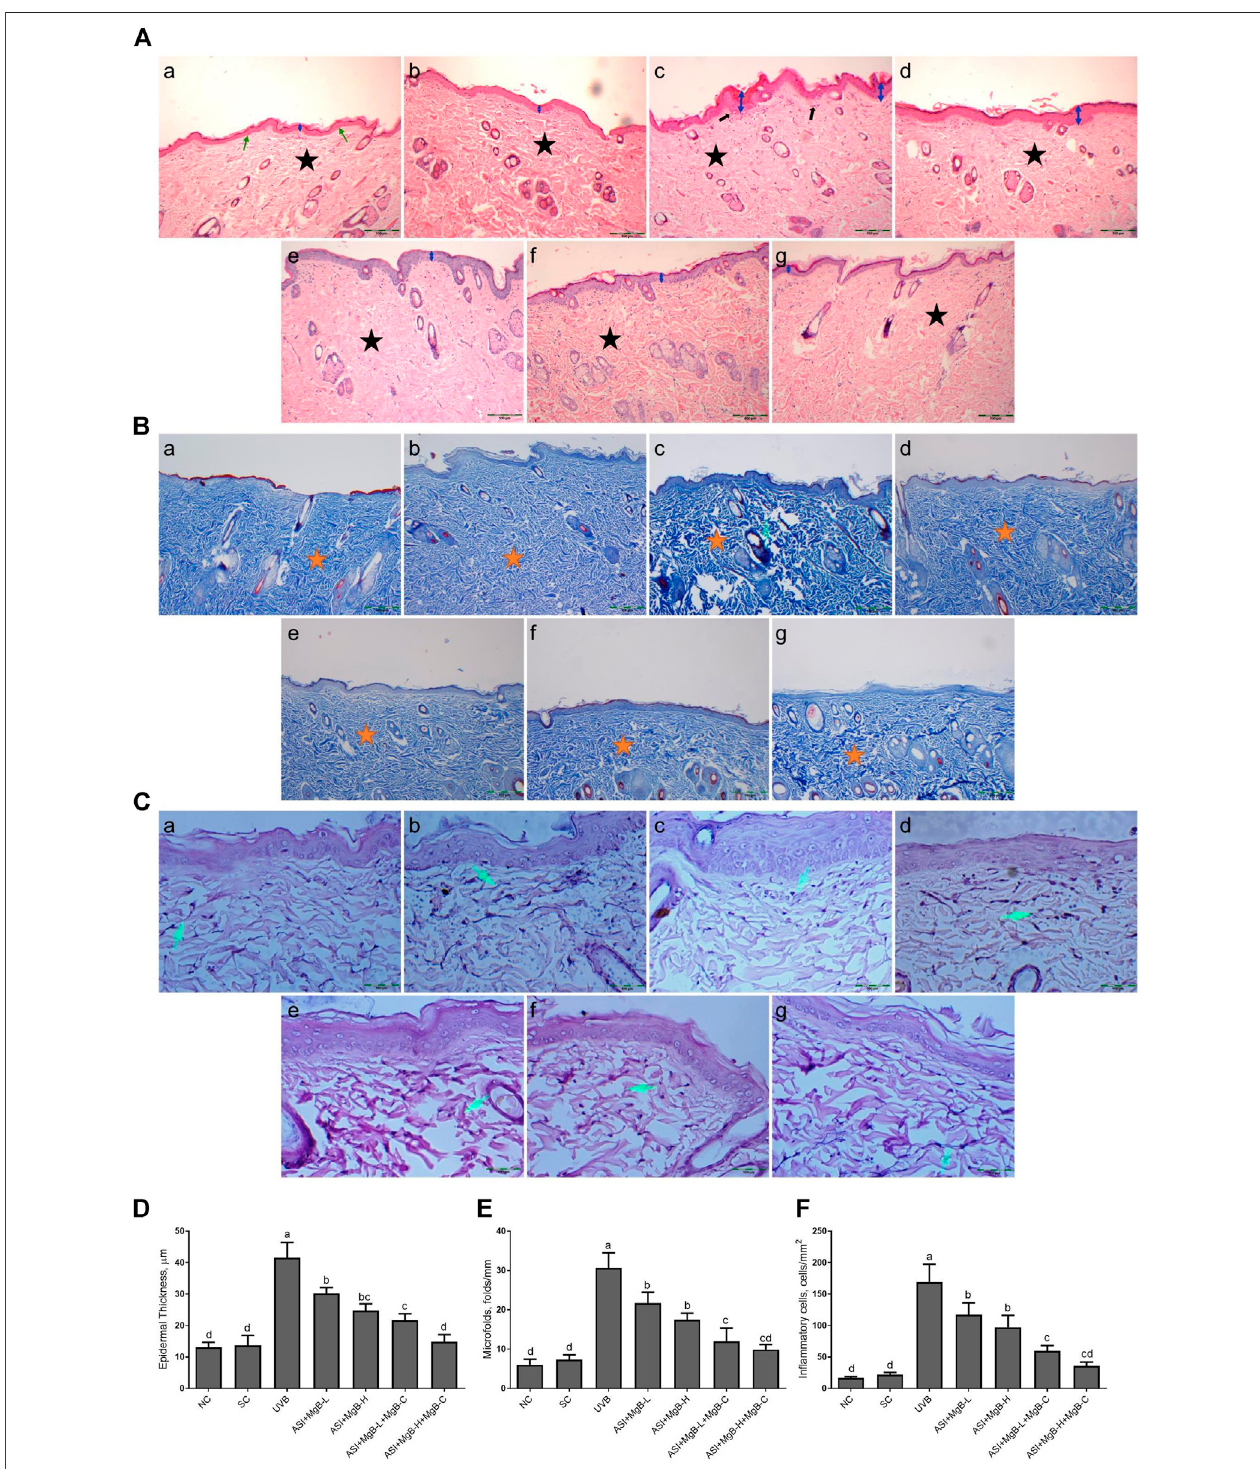
FIGURE 1 | Effect of inositol-stabilized arginine silicate complex (ASI) and magnesium biotinate (MgB) on histopathological changes of skin tissue stained with hematoxylin and eosin (H&E, 100X; A ), showing relative skin thickness, Masson ’ s trichrome (MT, 100X; B ), and Elastin (E, 400X; C ), and epidermal thickness (D) , microfolds (E) , and in fl ammatory cells (F) in rats with UVB-induced photoaging. In histopathological images, the groups are shown as a: NC (normal control; normal histology of epidermis and dermis (arrow) and tightly arranged collagen fi bers (star)); b: SC [shaved control; normal histology of epidermis and dermis (arrow) and tightly arranged collagen fi bers (star)]; c: UVB (An increase in epidermis thickness (double arrow) and loosely arranged dermal collagen fi bers (star); d : ASI + MgB-L; e: